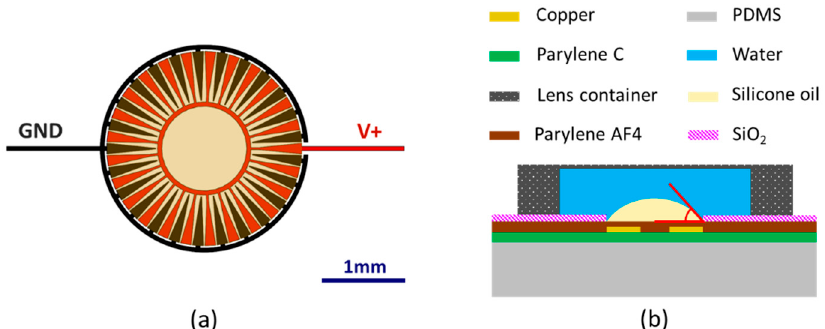
Figure 1. ( a ) Top-down view of areal-density-modulated electrode design, where live and grounded electrodes are interdigitated. The pale, yellow disk over the center of the electrodes highlights the area where the surface is hydrophobic, where the oil will initially pin. As voltage is applied the oil droplet will be symmetrically squeezed by the water which surrounds it. ( b ) Cross-section of a schematic of a single, fully assembled electrowetting lens (not to scale). The well for containing the liquids for electrowetting was affixed with adhesive, and a silicone oil droplet was placed over the hydrophobic region of the flexible dielectric surface defined by the patterned SiO 2 before being surrounded by water and sealed into the well. The red angle indicates the contact angle of the oil droplet.